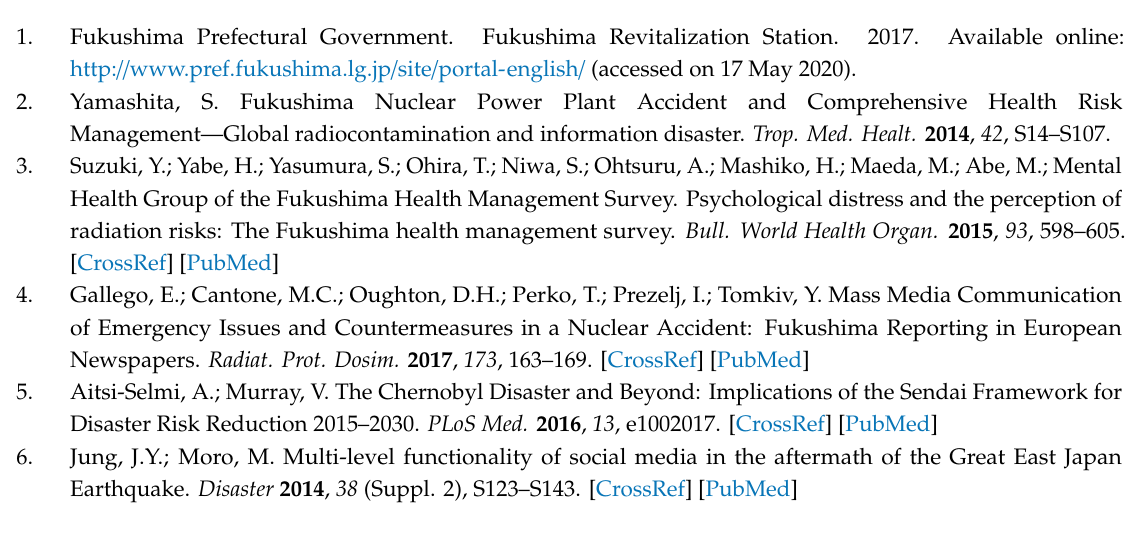
Table S1: Characteristics of media users relating to nuclear exposure (forced evacuees). Table S2: Characteristics of media users relating to nuclear exposure (voluntary evacuees). Table S3: Prevalence of current health anxiety due to radiation